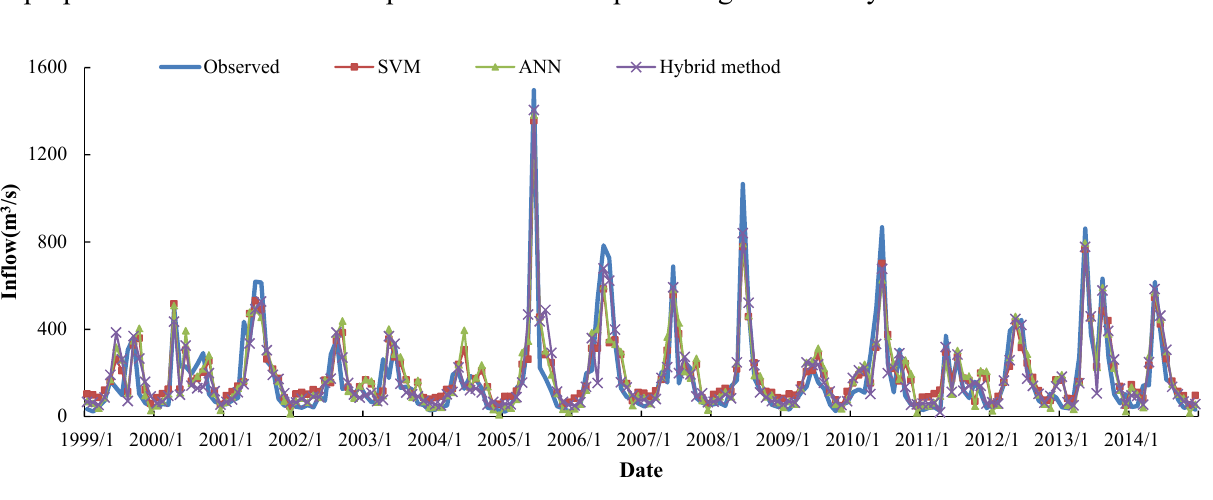
Figure 9. Comparison of forecasted versus observed data by various methods during the validation